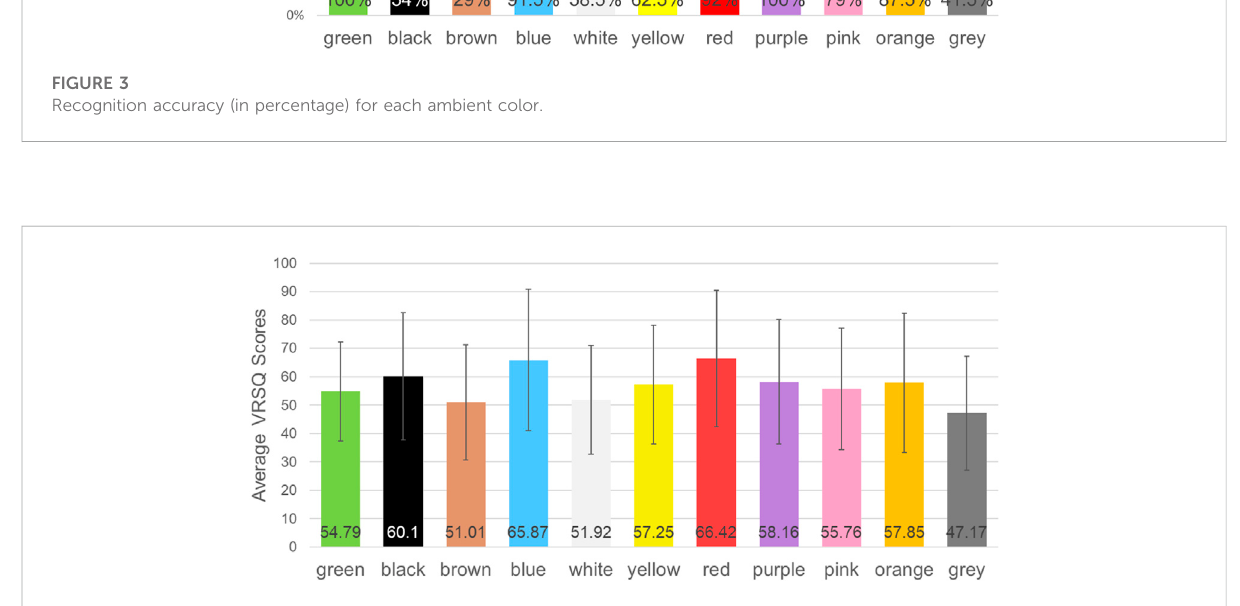
FIGURE 4 Average VRSQ scores for each ambient color, the error bars represent the standard